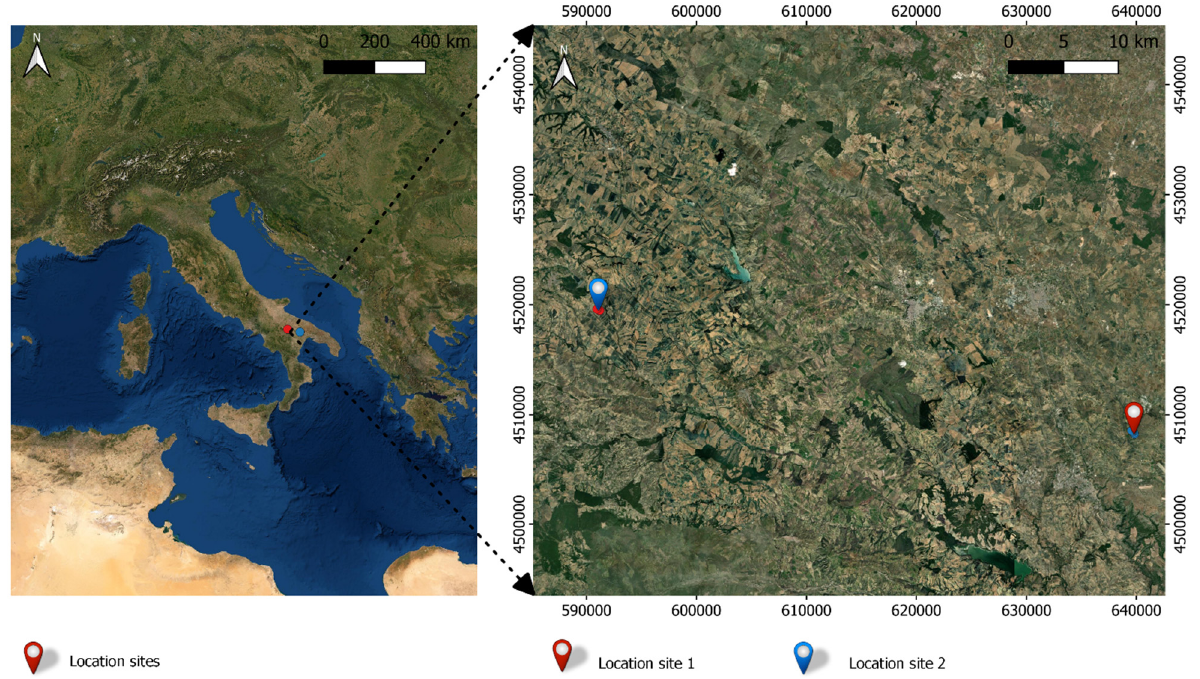
Figure 1. Location of experimental sites.